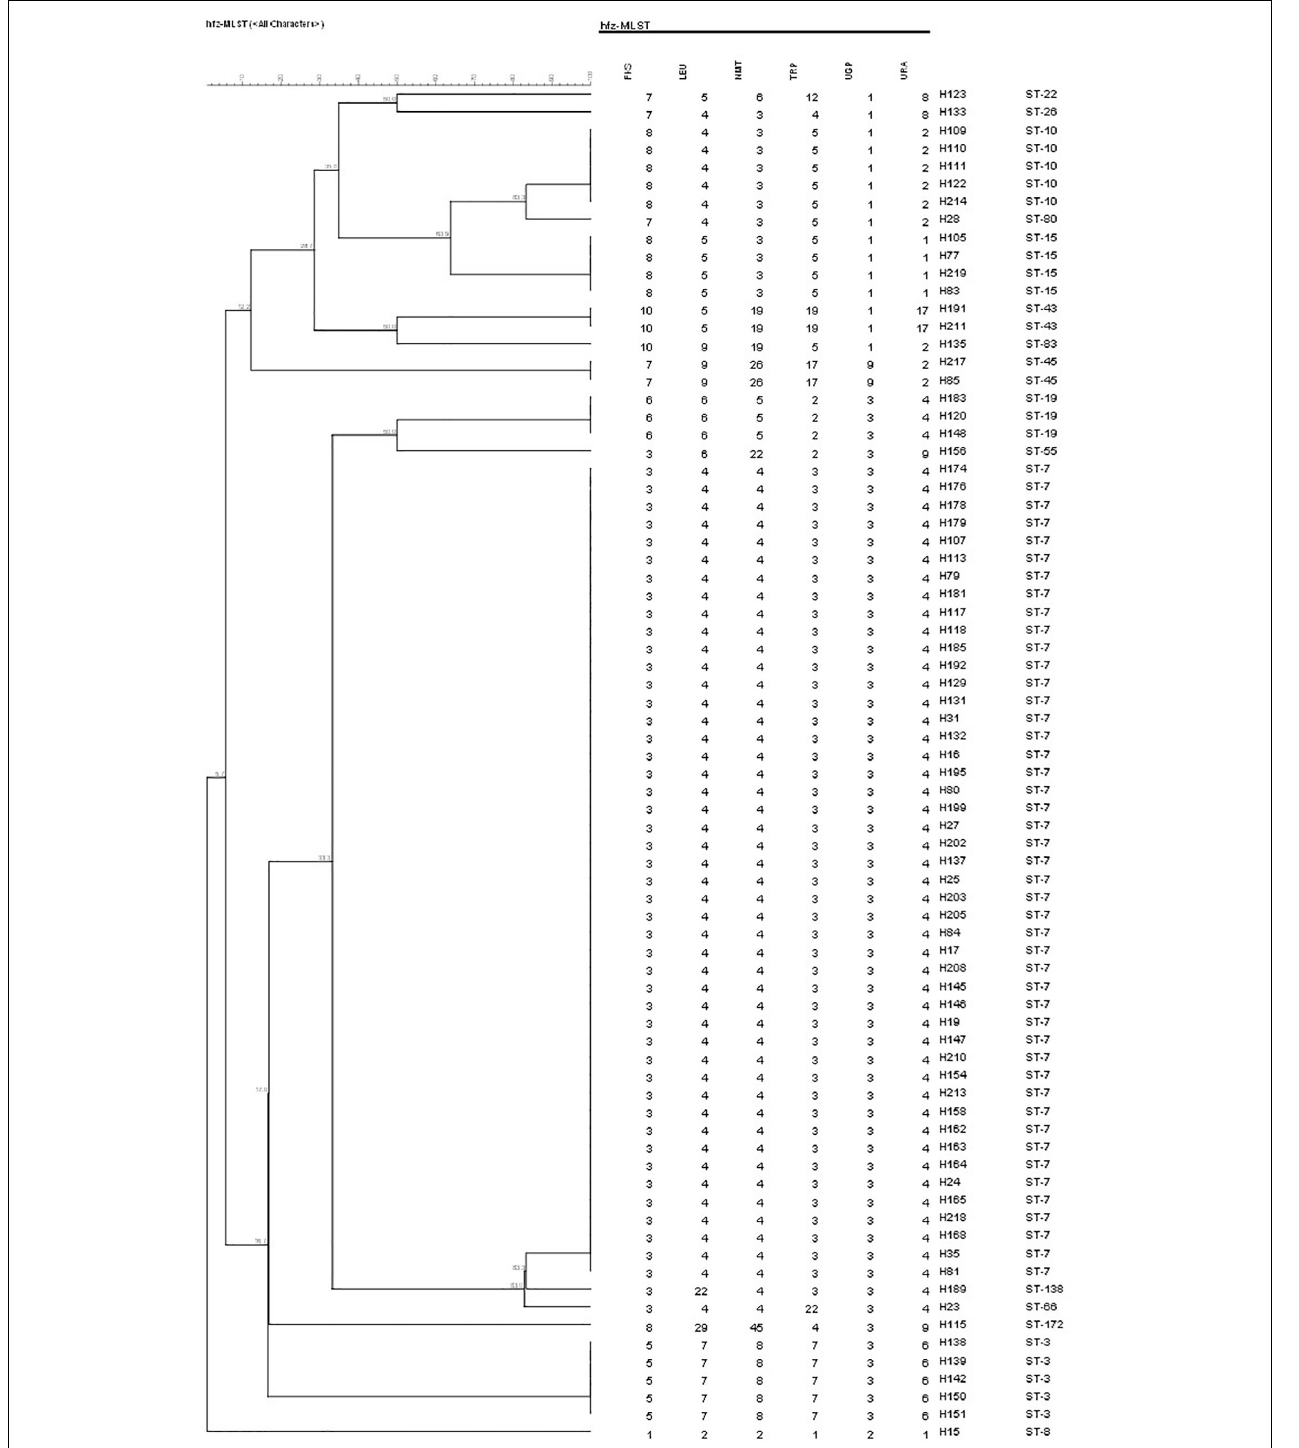
FIGURE 1 | Unweighted pair group method with arithmetic means dendrogram via BioNumerics software (version 7.6) showing the similarities among C. glabrata isolates. A similarity exceeding 80% was considered clonally related. The dendrogram demonstrates the genotyping of 76 vaginal C. glabrata isolates collected in the Obstetrics and Gynecology Hospital of Fudan University. Sequence similarity was observed between ST10 and ST80 (83.3%), ST7 and ST138 (83.3%), and ST7 and ST66 (83.1%).